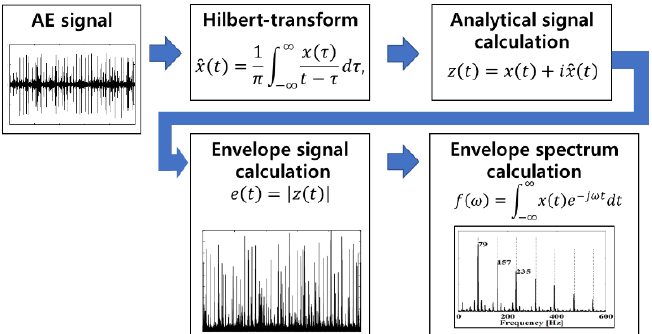
Figure 2. The flowchart of the envelope analysis. Hilbert-transform is applied to the acoustic emission (AE) signal to calculate the 90-degree phase-shifted signal. Then, the analytical signal is calculated by sum of the original signal and its Hilbert-transform as an imaginary number. Next, the envelope signal is calculated by applying absolute operation to the previously computed analytical signal. Finally, the fast Fourier transform of the envelope signal provides an envelope spectrum.